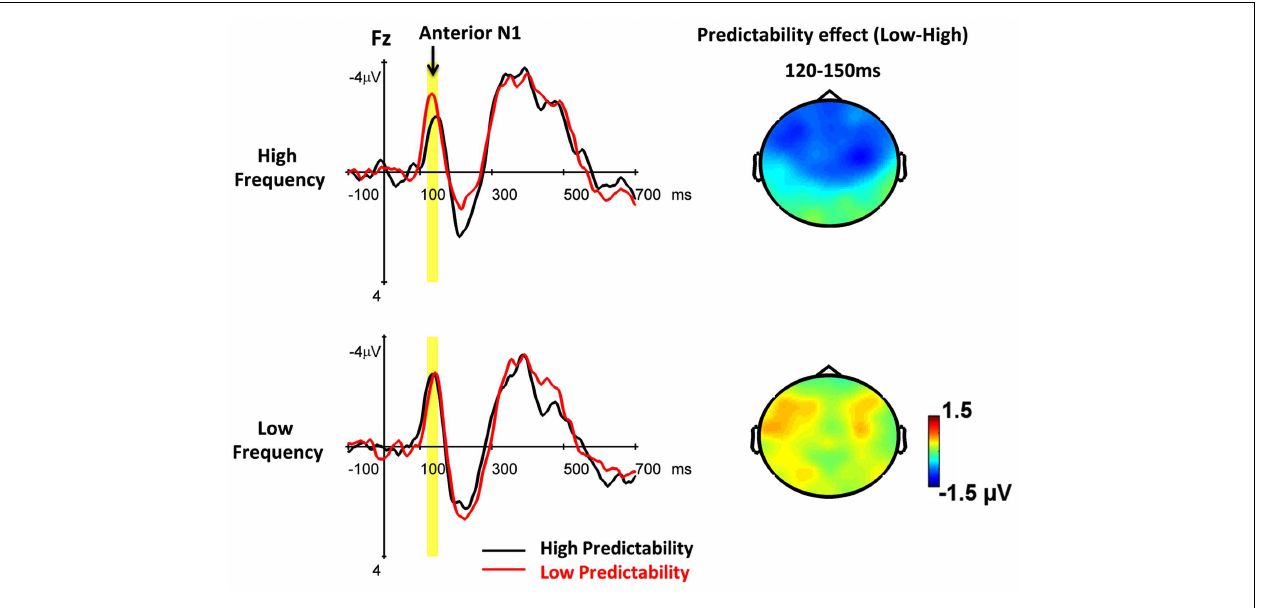
(120–150ms) of the anterior N1.The topographic maps show the predictability effects (low minus high) for high and low frequency words, respectively.